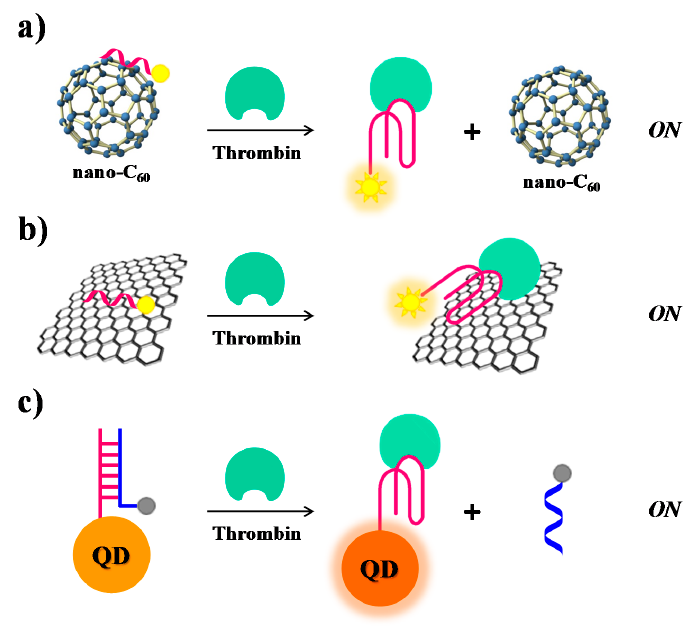
Figure 10. Schematic representation of thrombin detection strategies based on